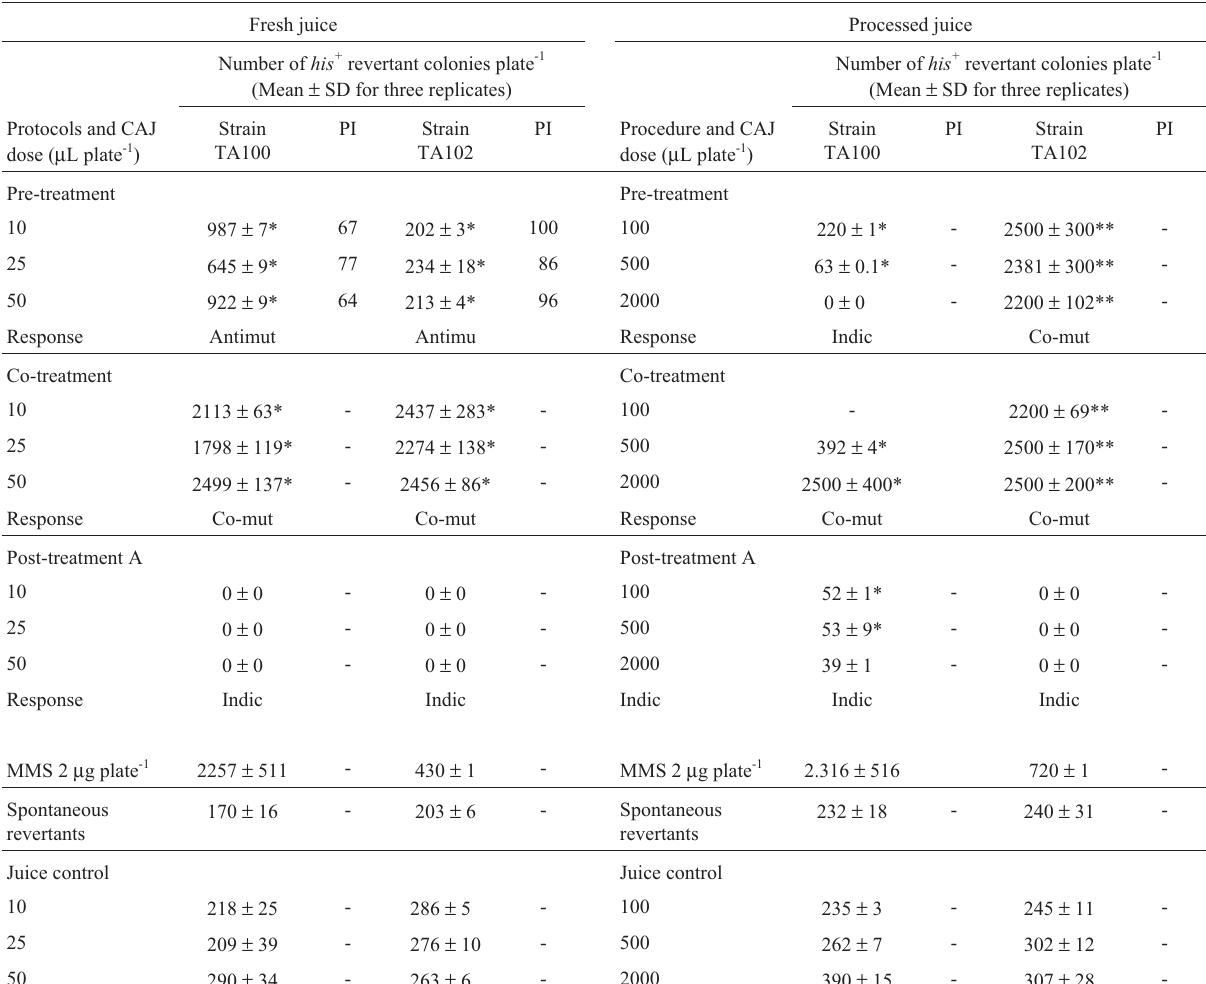
Table 1 - Effects of cashew apple juice (CAJ) against methyl methanesulfonate (MMS) using Salmonella typhimurium strains TA100 and TA102 as indica- tor organisms. Percentage inhibition (PI) calculated as PI = [1 - (B - A/B)] X 100, where A represents plates containing mutagens and B represents the plate containing mutagens and juice. Antimutagenicity = PI ≥ 50%. Indication of toxicity when the number of revertant colonies < 70% compared to number of spontaneous revertants. Co-mutagenicity when there is a significant increase in mutagenicity as compared to positive control. The number of spontaneous revertants was subtracted from all plates. Values are means ± standard deviations (SD). Protocols for CAJ testing: pre-treatment, juice + bacteria in fresh nu- trient broth for 4 h, wash bacteria and add mutagen for 20 min, wash bacteria and plate; co-treatment A, juice + mutagen for 20 min, add to the bacteria and plate; and post-treatment A, bacteria + mutagen for 20 min, wash bacteria, add the juice and